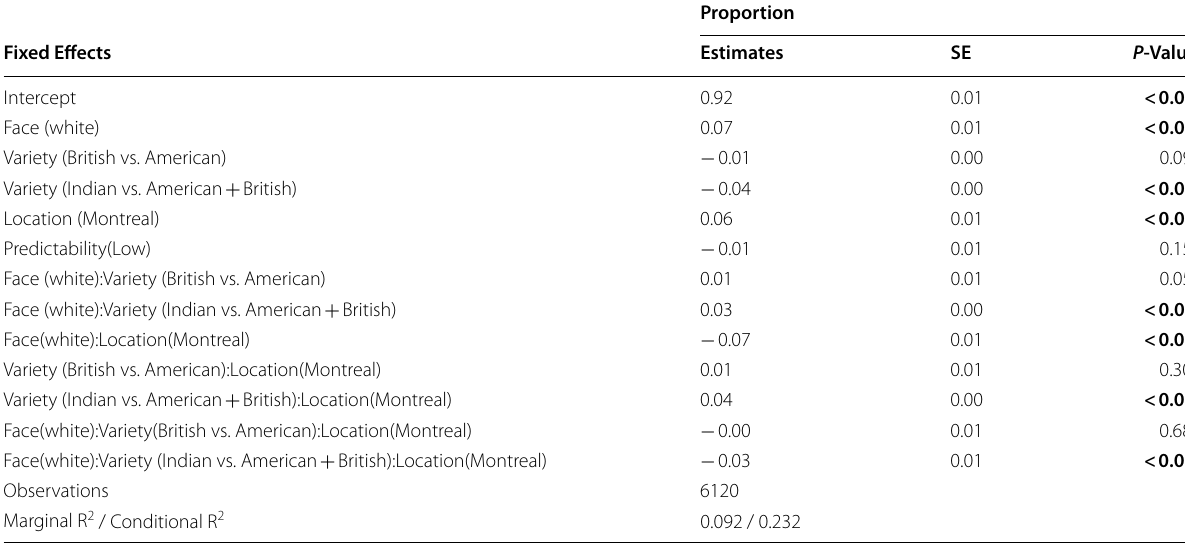
Significant results are in bold